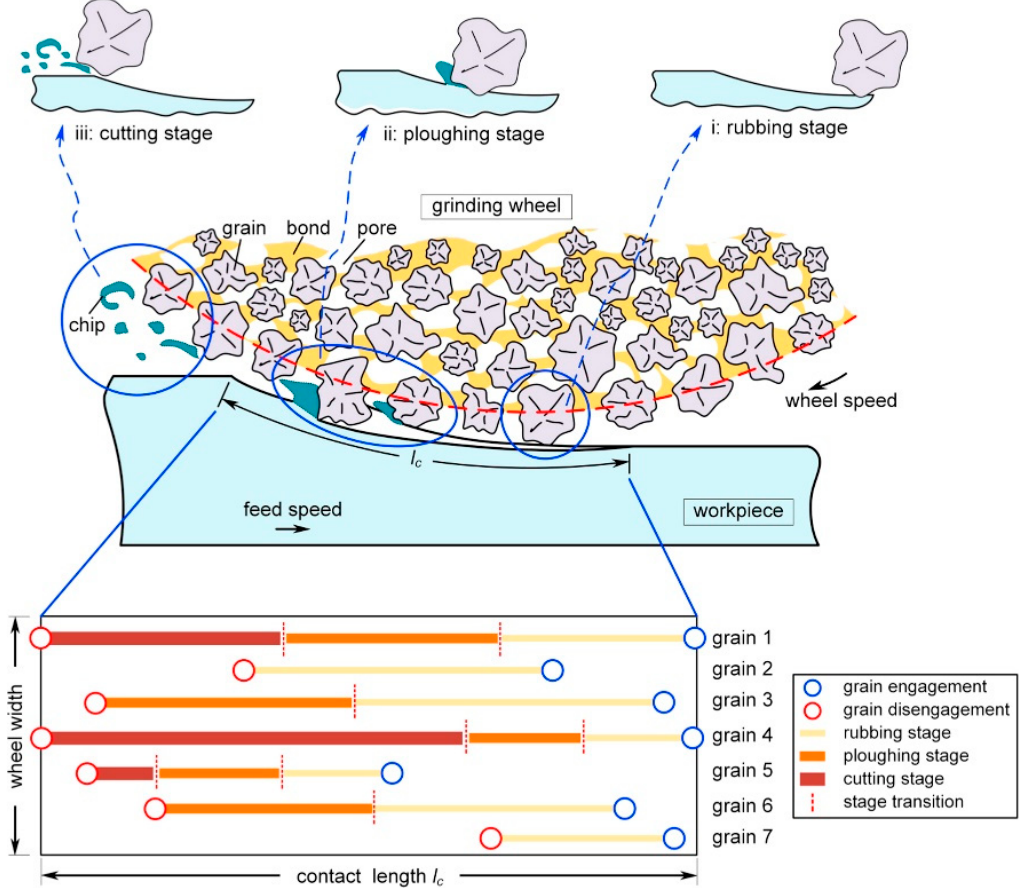
Figure 2. Schematics of contact stages between the abrasive grit and workpiece during grinding: rubbing, ploughing, and cutting [5].